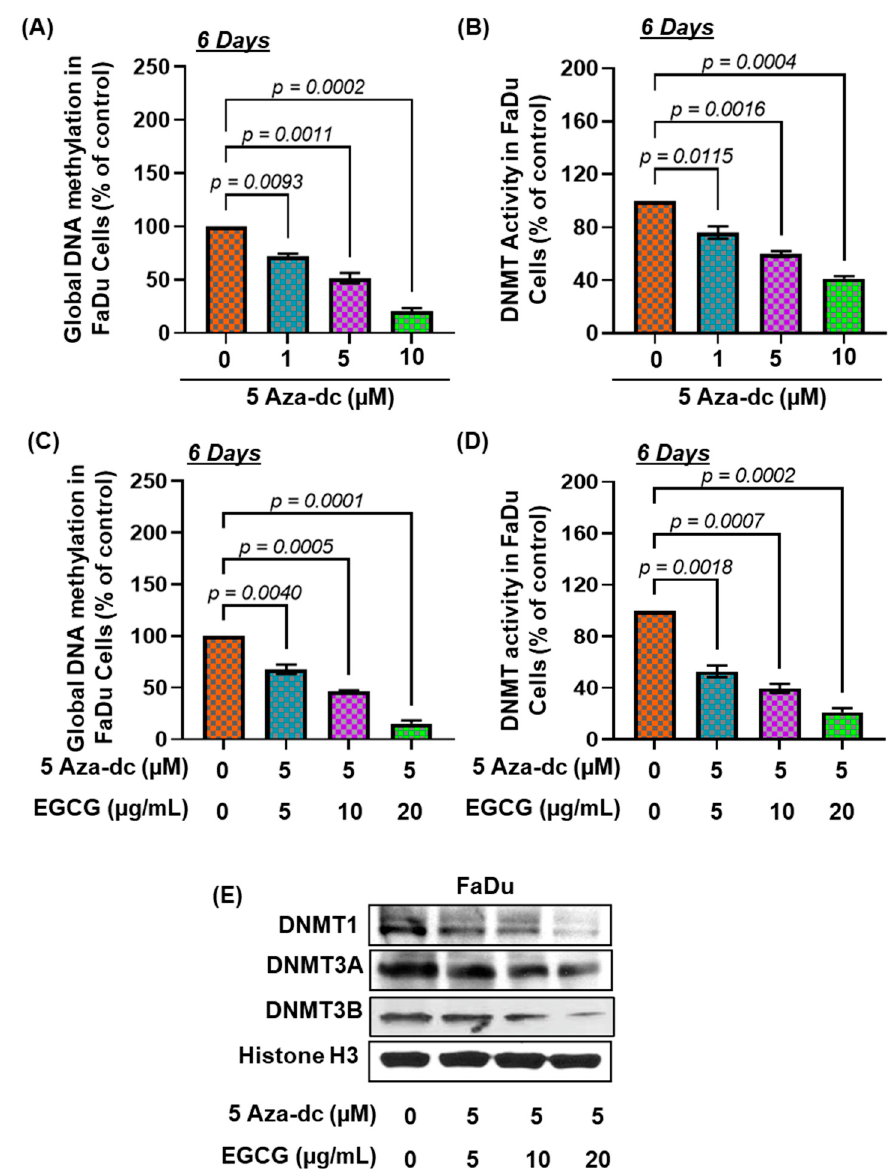
Figure 4. EGCG treatment synergistically modulates 5Aza-dc effects on DNA methylation and DNMT activity. FaDu cells were treated with 5Aza-dc in a dose-dependent manner for 6 days. The levels of global DNA methylation ( A ) and DNMT activity ( B ) in nuclear extracts were determined using global DNA methylation and DNA methyltransferase activity assay kit. The combined effect of EGCG and 5Aza-dc was observed on the expression level of global DNA methylation ( C ) and DNMT activity ( D ). Data are presented in terms of percentage versus non-EGCG-treated controls, which was assigned a value of 100%, and as means ± S.E.M from three independent experiments. A significant difference was observed versus non-EGCG-treated controls. The levels of DNMT1, DNMT3a, and DNMT3b in nuclear lysates of FaDu cells were determined using Western blot analysis after the combined treatment ( E ).